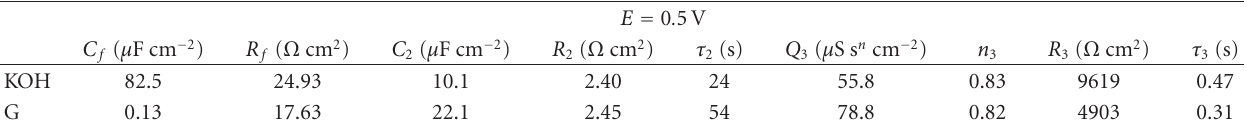
Table 3: Circuit parameters obtained by fitting the experimental impedance results with the selected equivalent circuit. Data obtained under irradiation ( λ = 365nm) in the presence and in absence of glycerol, E = 0 . 5 V. E = 0 . 5V